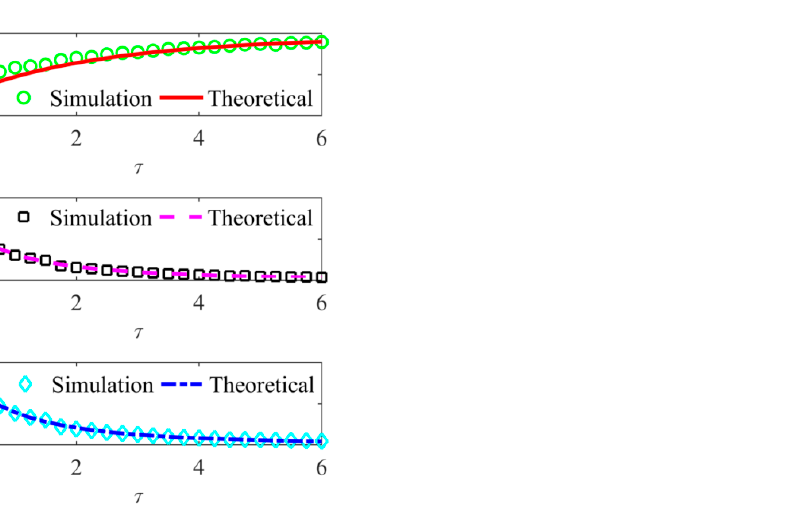
8 of 15 Figure 4. Influence of ( a ) quadratic coefficient and ( b ) cubic coefficient on the mean displacement, mean square voltage, and power output. Furthermore, Figure 5 explains the influence of correlation time on the response of asymmetric potential MEH. It is seen that the mean displacement increases with an in-